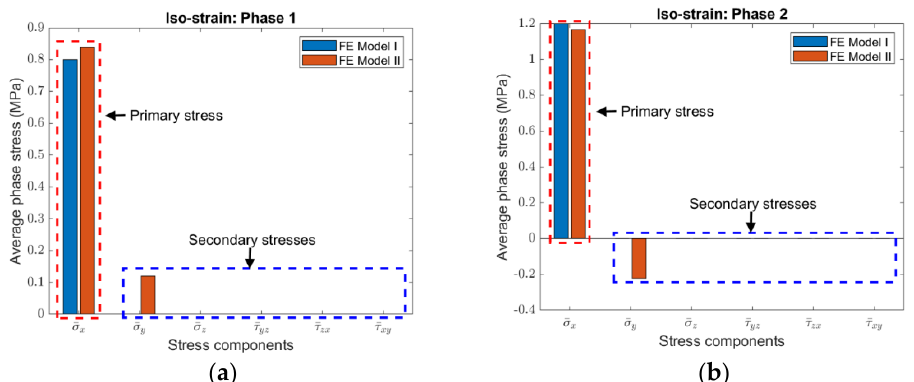
Figure 3. Average stresses in ( a ) Phase 1 and ( b ) Phase 2 of Composite #2 under the iso-strain condition (The volume fraction Phase 2 is 0.35).